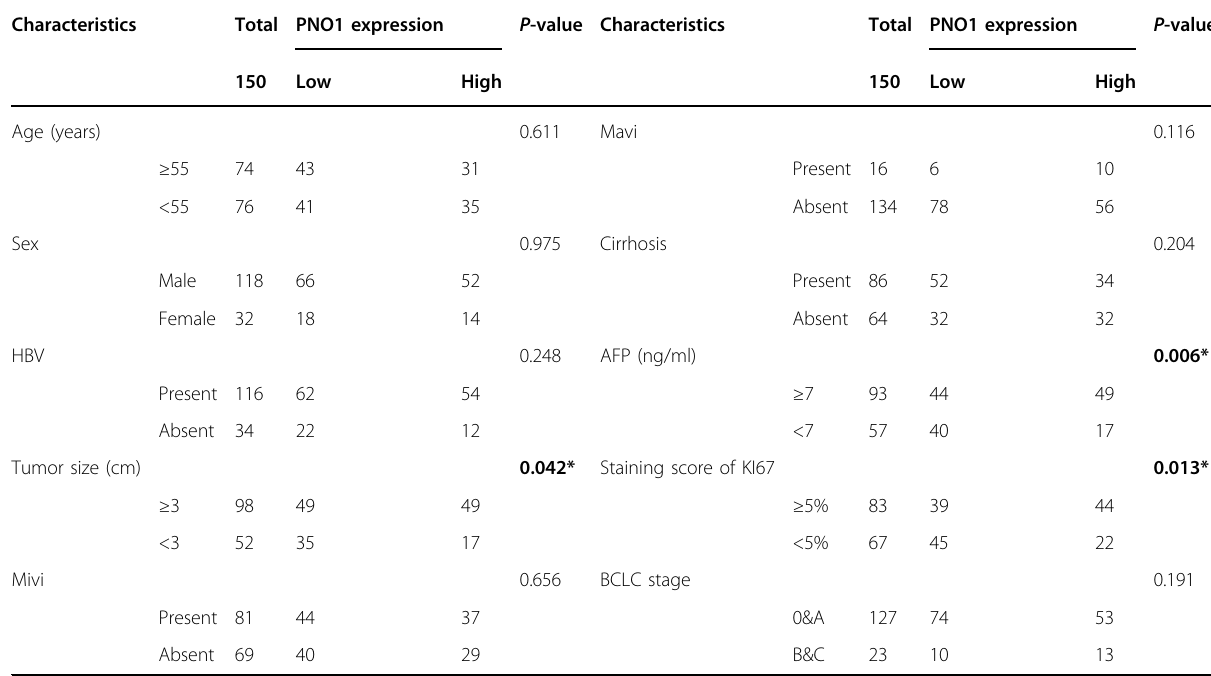
Table 2 Relationship between clinicopathological characteristics and PNO1 expression in 150 HCC patients.